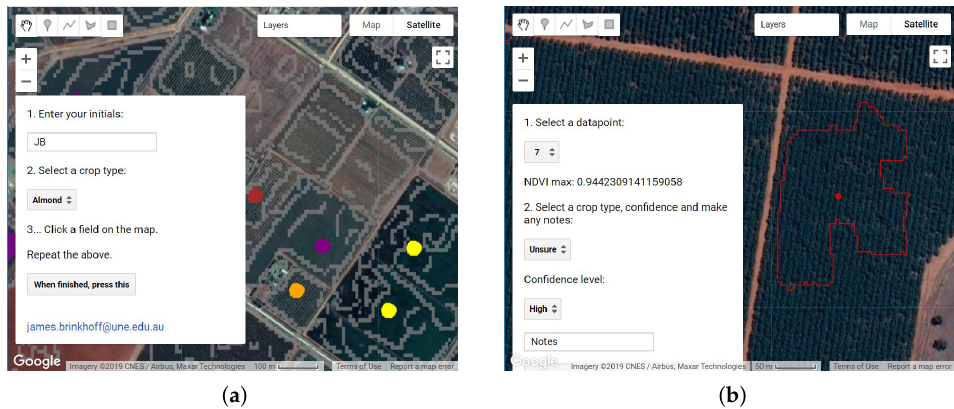
Figure 5. Web apps for collecting ( a ) training and ( b ) validation data.